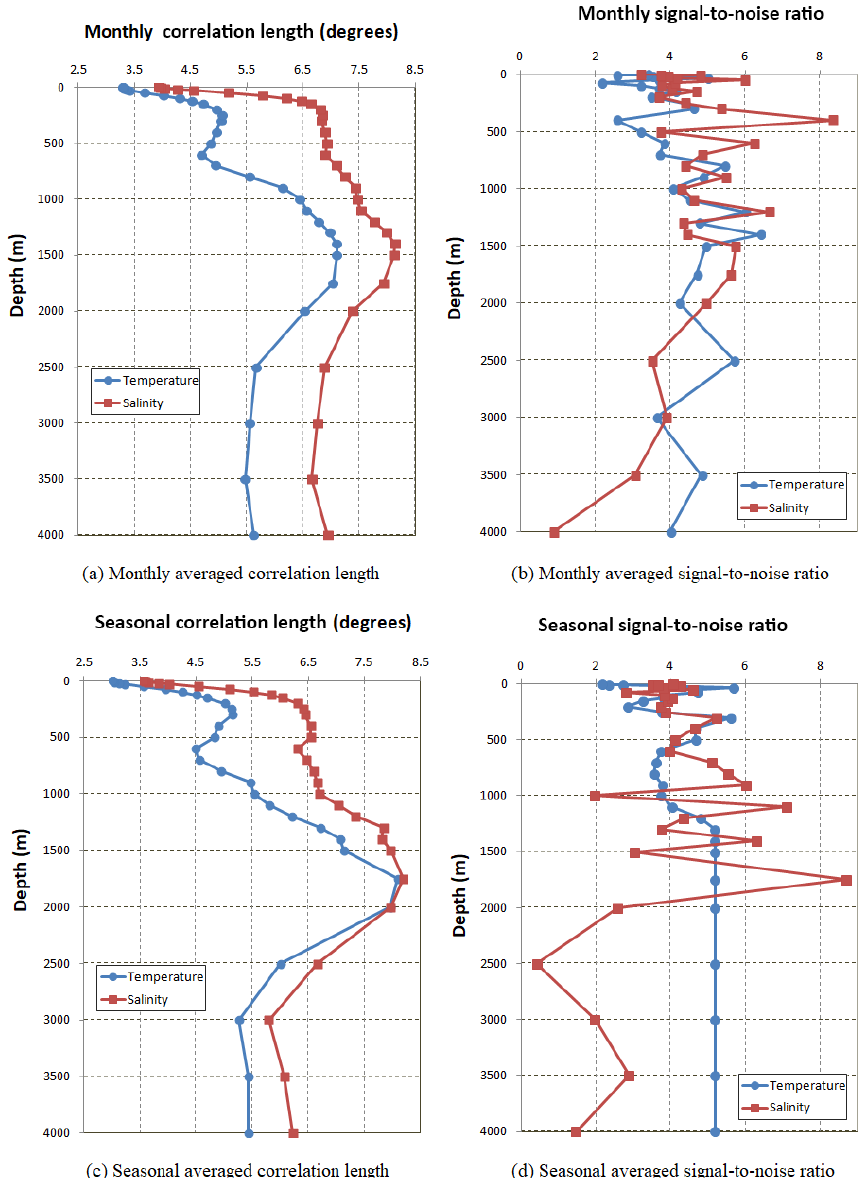
Figure 3. Averaged profiles of correlation length (a, b) and signal-to noise ratio (c, d) for temperature and salinity.